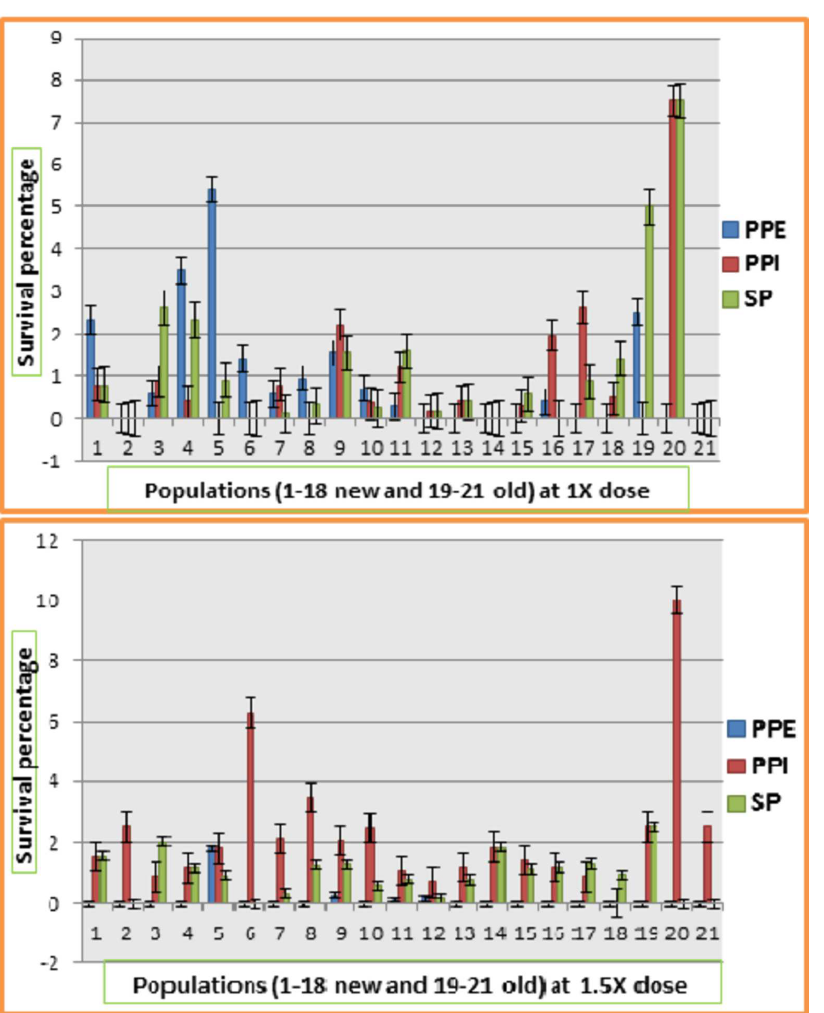
Fig 4. Response of 21 populations of lentil for survival percentage at different doses of Ally max at three different screening